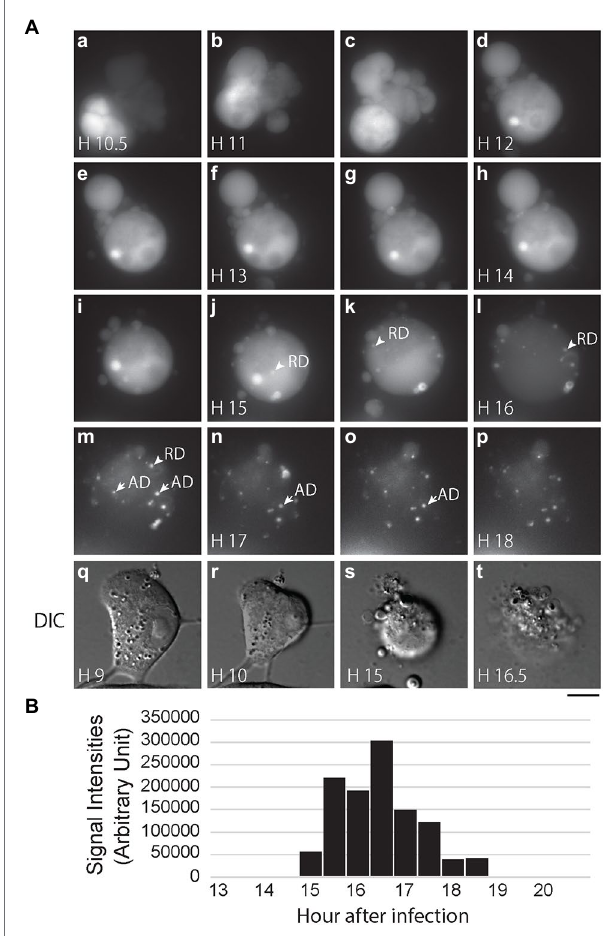
TABLE 2 | Inhibition of vRNA replication by an apoptosis inhibitor. a,d